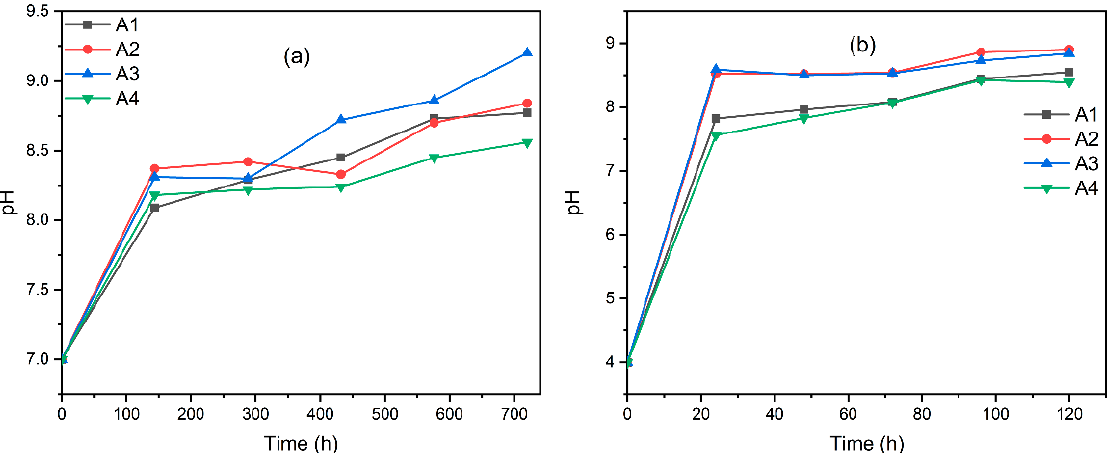
Figure 4. pH variation versus immersion time of the prepared glasses in deionized water ( a ) and in HCl solution ( b ).